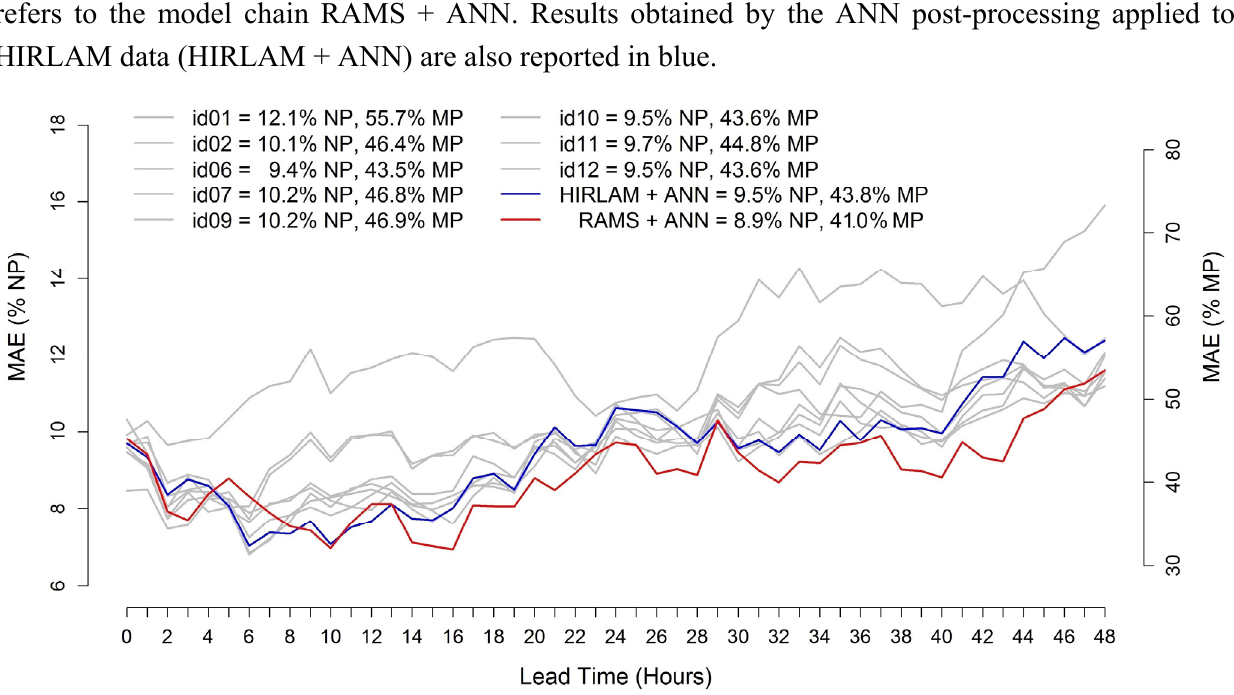
Figure 6. Error trends of the 0–48 h ahead wind power forecasts starting at 12 UTC for the Klim test case ( MAE / NP % and MAE / MP